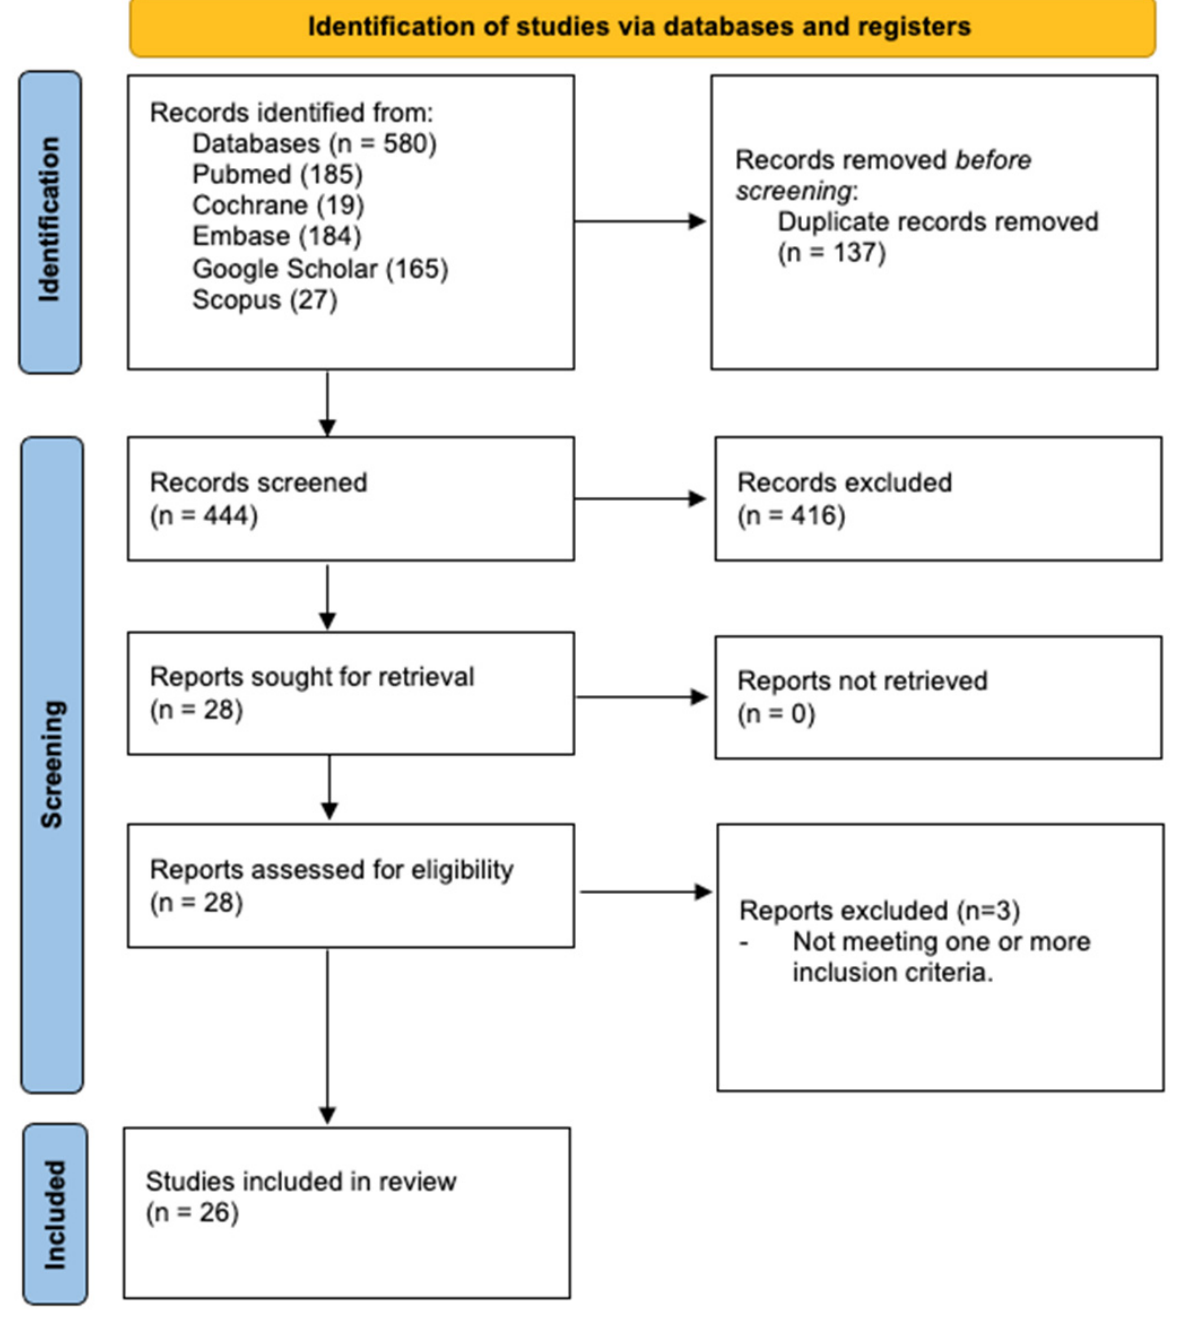
Figure 1. Prisma Flow Diagram.